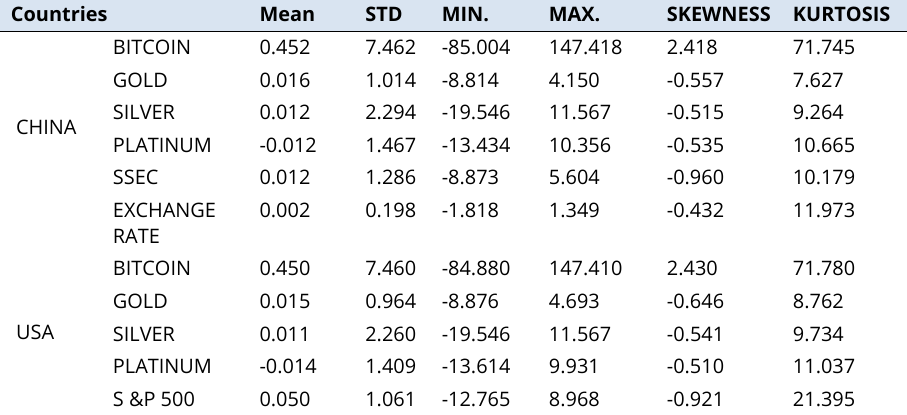
Descriptive statistics of returns of Bitcoin, precious metals, stock indexes and exchange rates risk in the USA and